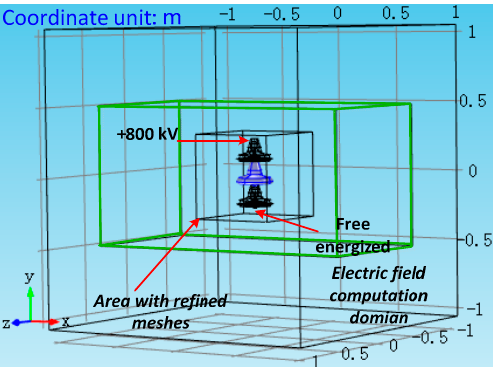
Figure 9. Electric field simulation diagram for the transmission line insulator sample (the coordinates are by meter).